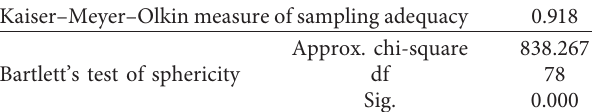
Table 5: KMO and Bartlett sphere